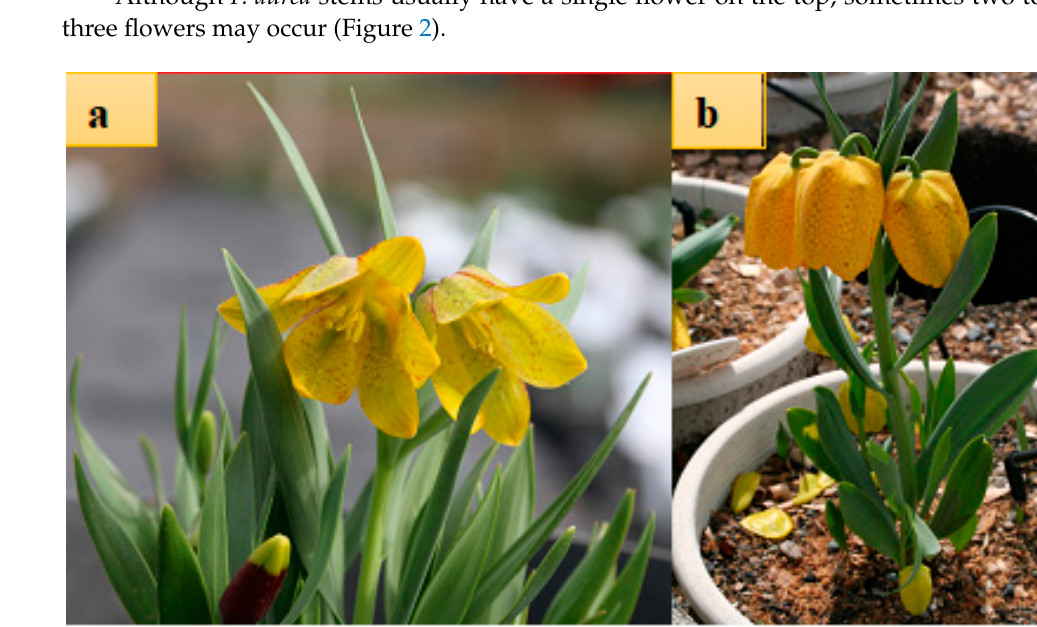
Figure 2. A view from in-situ ( a ) and ex-situ ( b ) habitat of F. Aurea (Photo; M. Aslay original)..